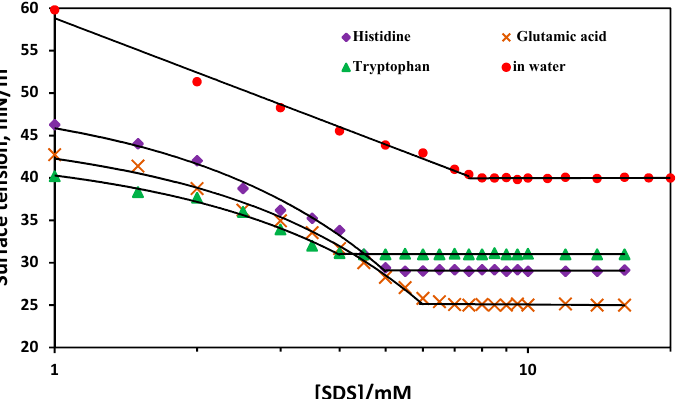
Figure 4. Surface tension plots of SDS solutions as a function of concentration in water and the 0.01 M of different AAs at 20 °C.